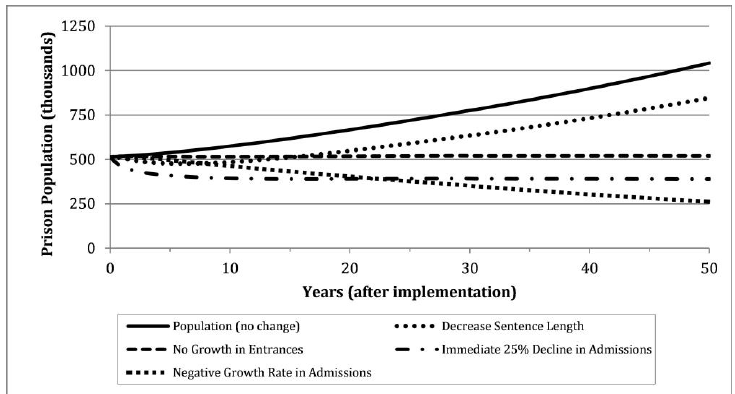
Figure 1. Nonviolent Inmate Population, Changes in Policies for Nonviolent Offenders. Source: Calculations by author using Bureau of Justice Statistics data.